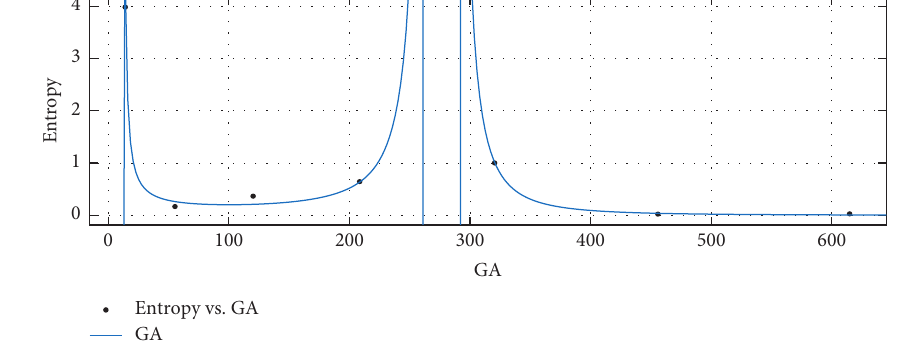
Figure 16: GA versus